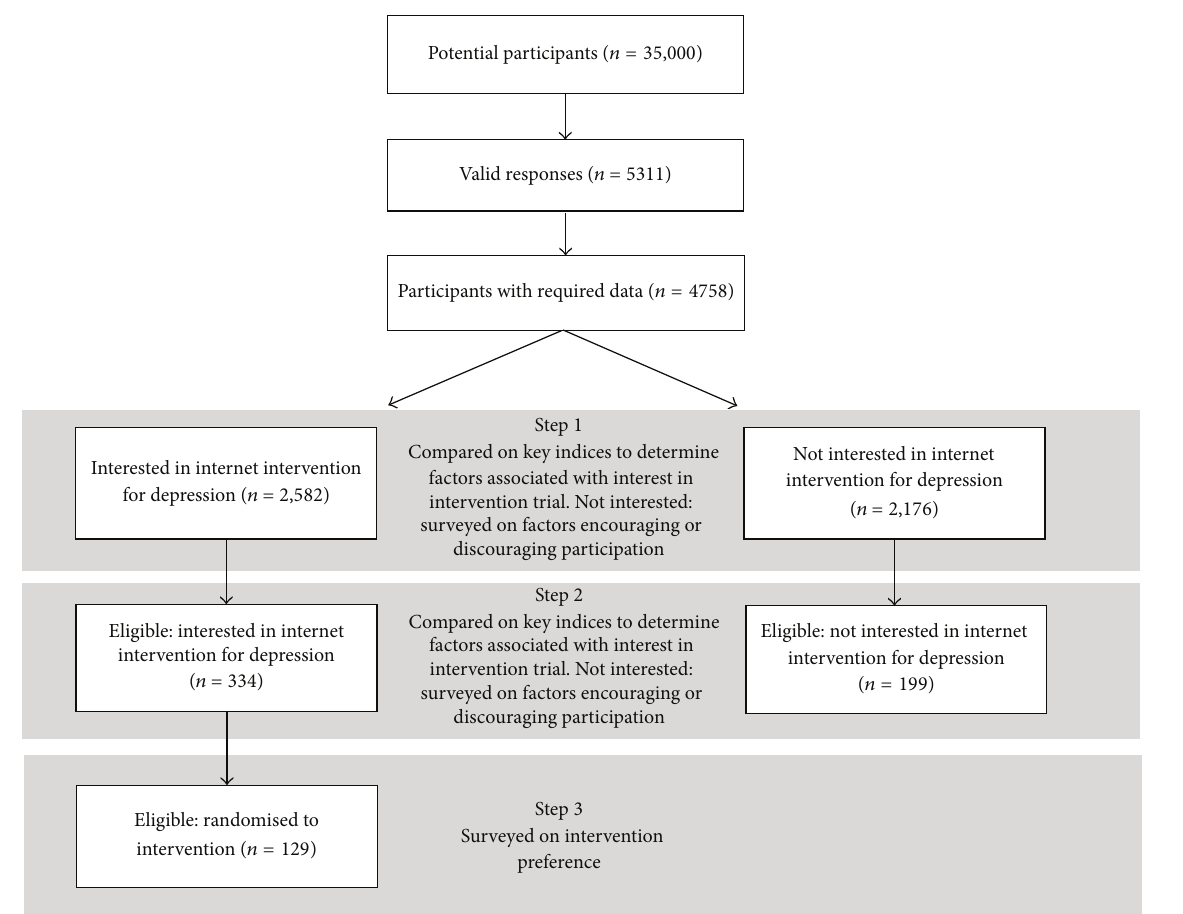
Figure 1: Flow diagram illustrating participant